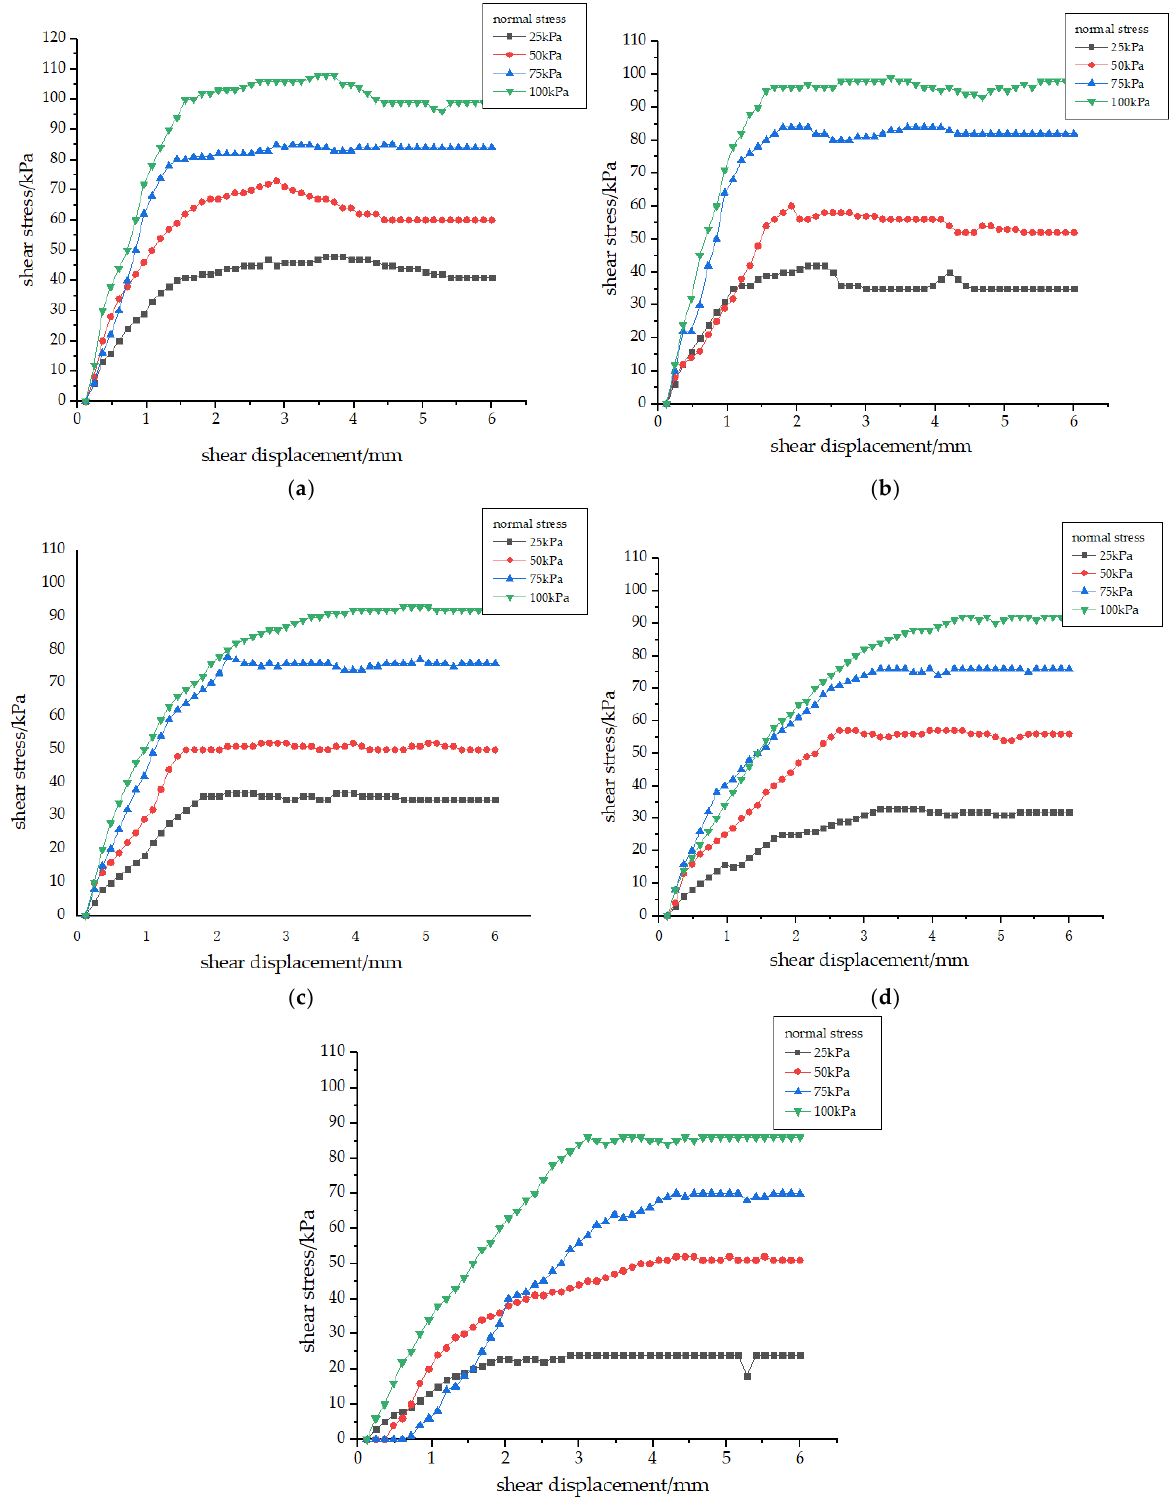
Figure 7. The relationship between shear stress and shear displacement under different moisture contents. ( a ) Moisture content 5.30% (degree of saturation 20%); ( b ) Moisture content 10.60% (degree of saturation 40%); ( c ) Moisture content 15.85% (degree of saturation 60%); ( d ) Moisture content 21.10% (degree of saturation 80%); and ( e ) Moisture content 37.86% (degree of saturation